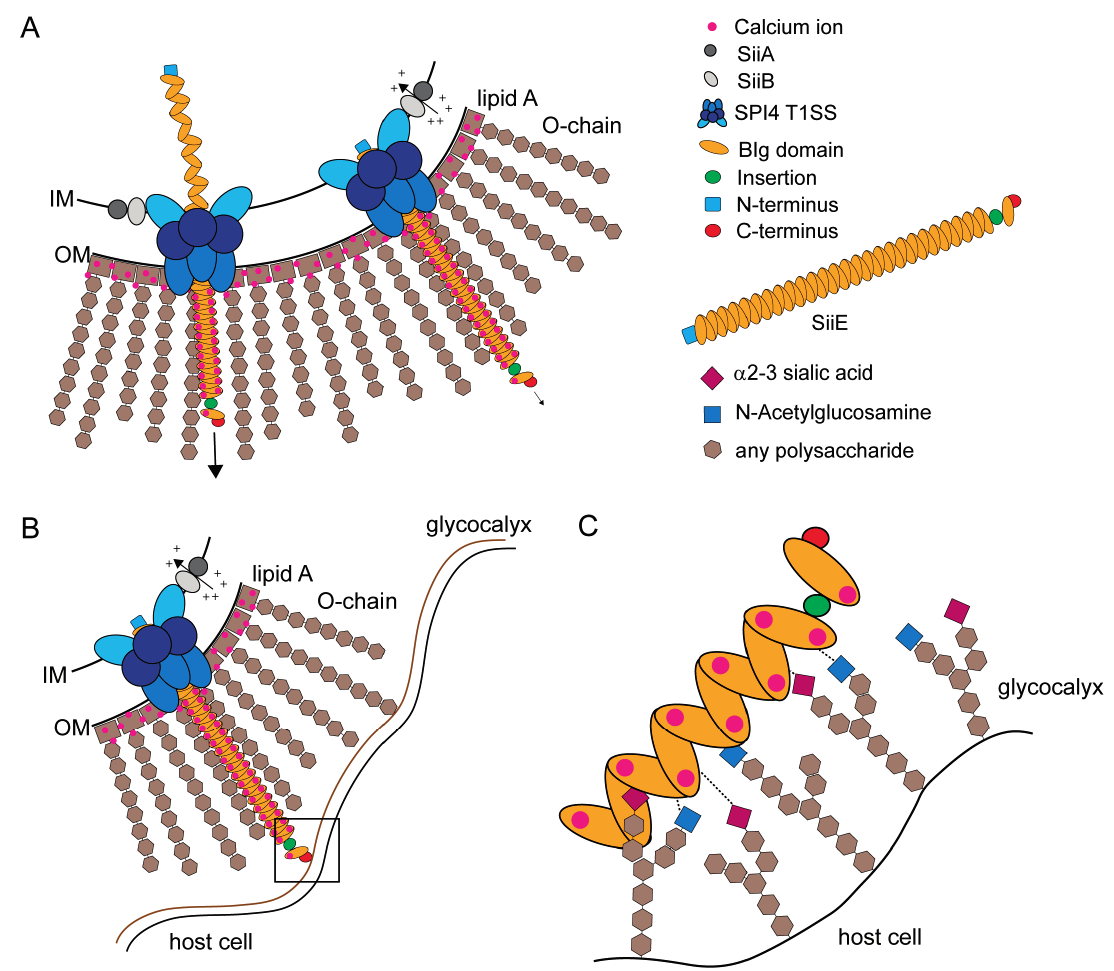
Figure 5. Models for SiiE secretion, surface retention and SiiE-mediated